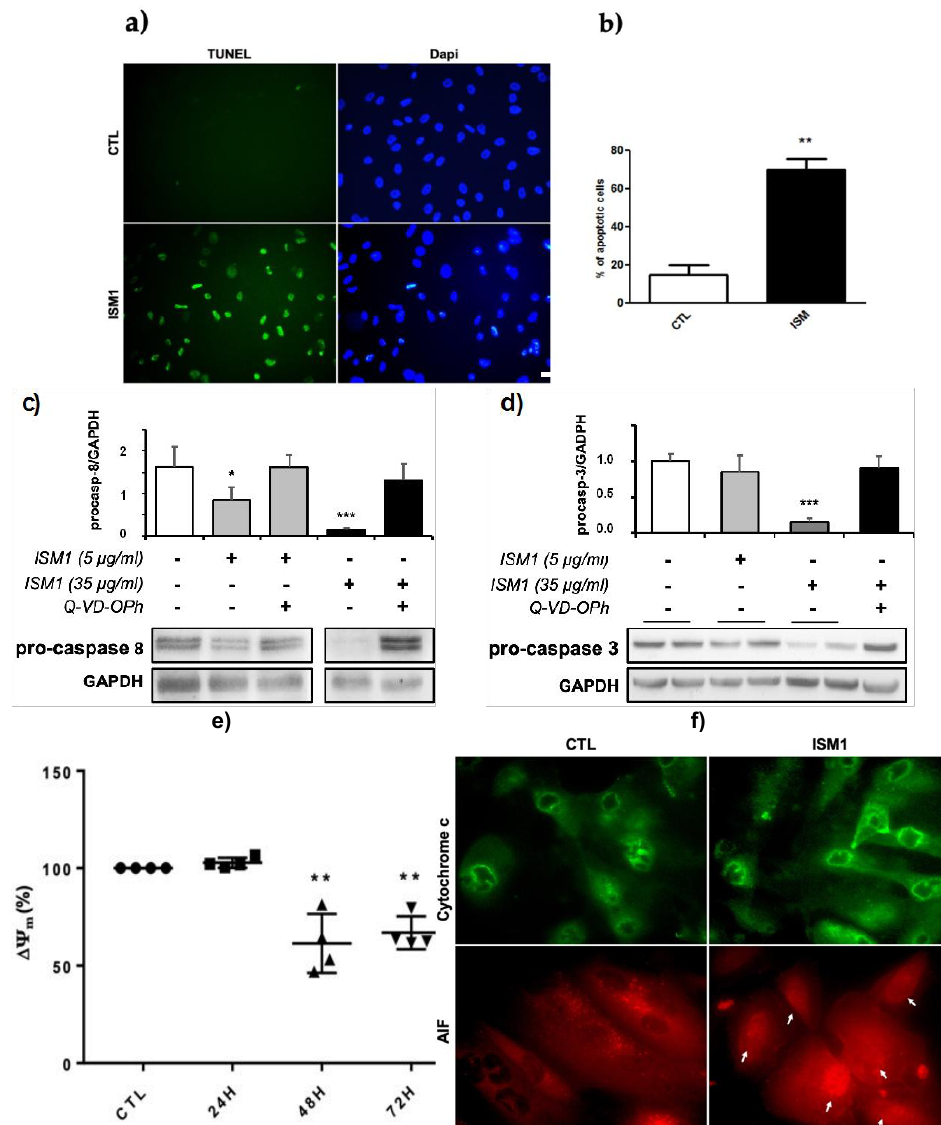
Figure 6. ISM1 induces apoptosis in podocytes. ( a ) Estimation of ISM1-induced apoptosis by TUNEL assay after un strong stimulus ISM1 (35 μg/mL) for 72 h. Cells were observed under fluorescence microscopy. ( b ) Apopotic cells were quantified. ISM1 induced an emergence of TUNEL positive cells corresponding to apoptotic cells (** p < 0.01 vs control group; n = 3). ( c,d ) Evidence of caspases activation. Representative immunoblots with quantitative data of densitometry are shown in ( c ) for caspase 8 and in ( d ) for caspase 3. ISM1induced the degradation of pro-caspases 8 and 3 (** p < 0.01; * p < 0.05 vs control group; n = 4 blots) this was inhibited by QVD-OPh. ( e ) ISM1 decreases the mitochondrial membrane potential of podocytes (ΔΨm). Podocytes were treated with ISM1 (35 μg/mL) and quantification of ΔΨm was assessed by the JC-1 probe. ISM1 decreased significantly the ΔΨm of podocytes from 48 h to 72 h (*** p < 0.01; ** p < 0.01 vs control group). ( f ) AIF was released from mitochondria to the cytosol and the nucleus after ISM1 treatment (arrows). In contrast, cytochrome c remained confined in mitochondria after ISM1 treatment. Bars = 50 μm for (a) and 20 μm for (f).